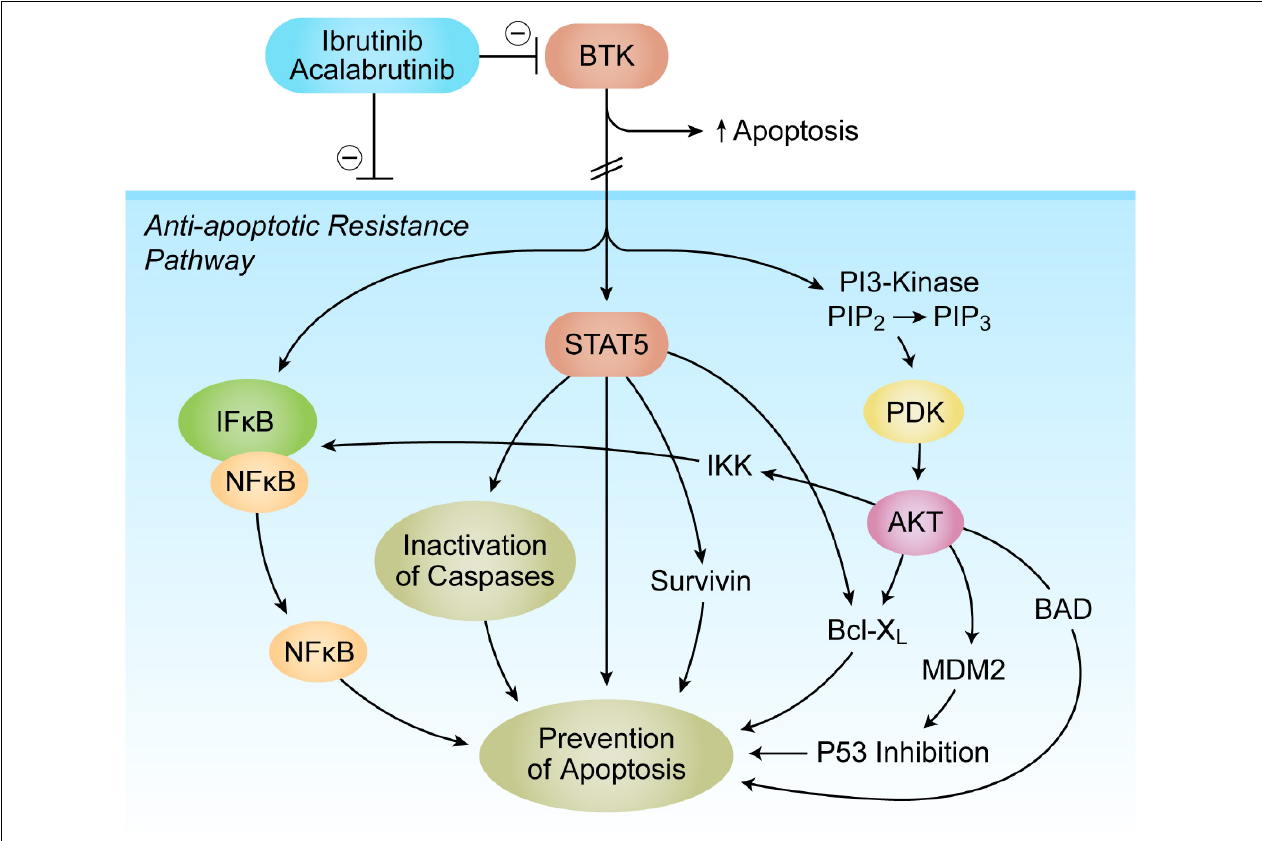
FIGURE 1 | Bruton’s tyrosine kinase (BTK) as a Master Regulator of Apoptosis in tumor microenvironment (TME). The anti-apoptotic BTK-PI3K-AKT signaling pathway is critical for the survival of tumor cells. Multiple antiapoptotic signaling molecules and pathways linked to NF- κ B, PI3-K/AKT, and STAT5 are regulated by BTK. See text for a detailed